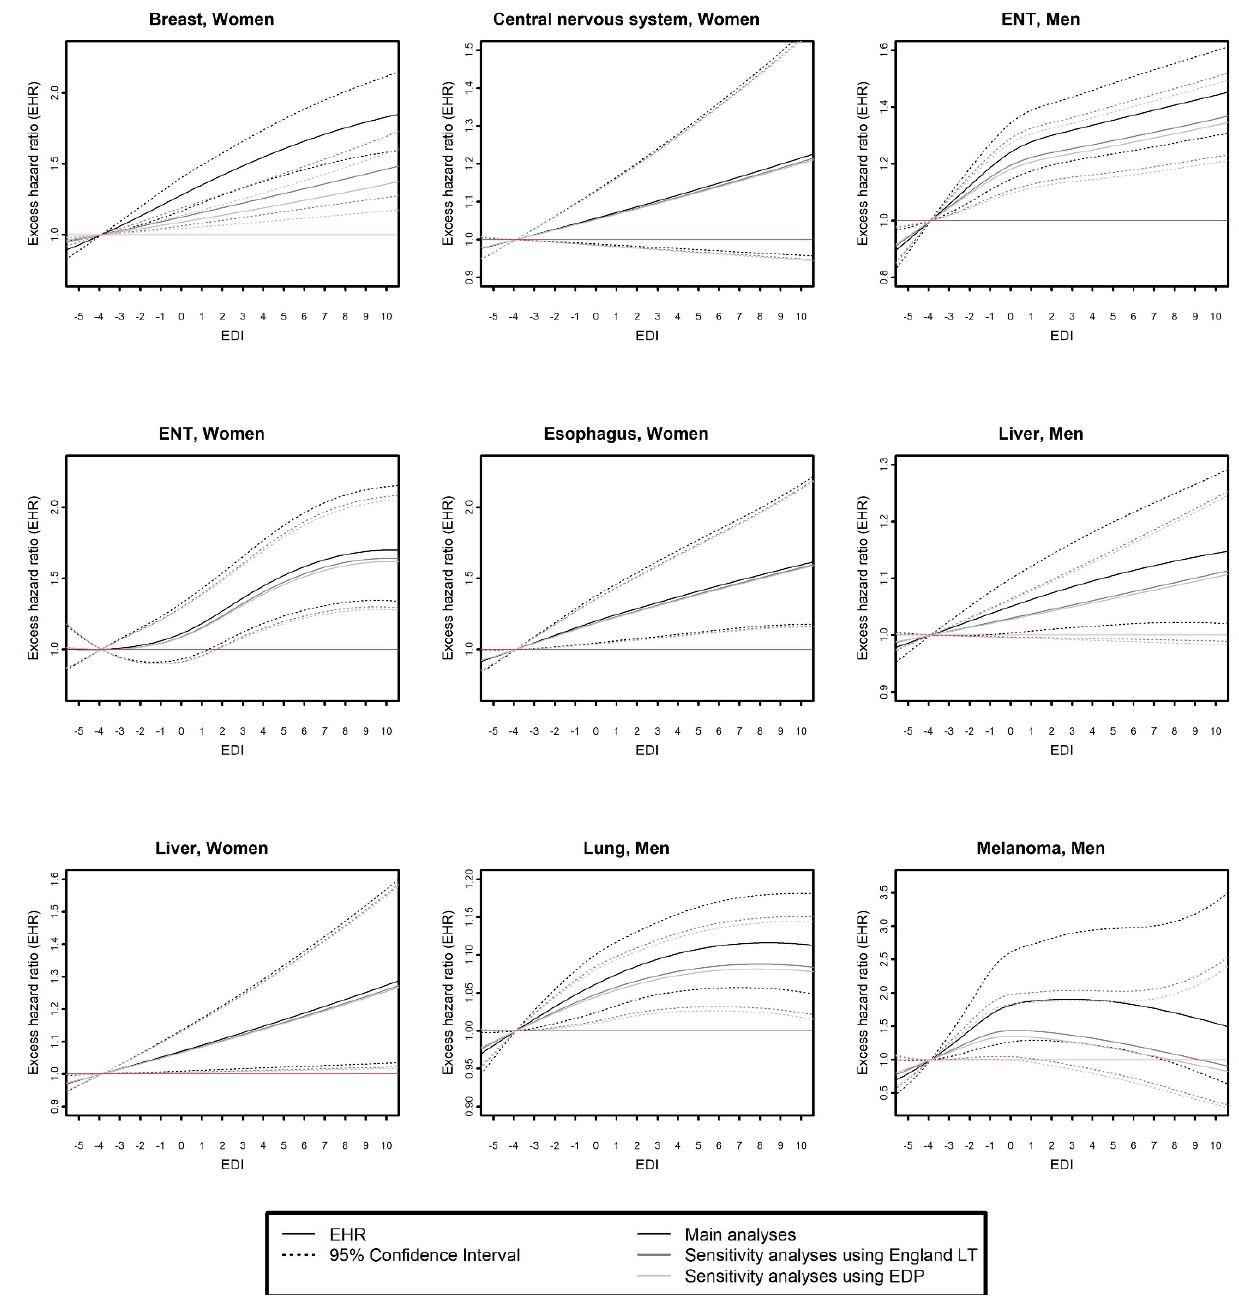
Figure 2. Excess mortality hazard ratio (EHR) as a function of deprivation (EDI) according to main analyses, sensitivity analyses using English life tables, and sensitivity analyses using EDP data, for cancer sites for which all three analyses were concordant (same flexible model selected), and model selection showed an overall proportional effect of EDI on excess mortality hazard (independent of age and time of follow-up). EDI: European Deprivation Index; EDP: French permanent demographic sample [Echantillon Démographique Permanent]; EHR: excess mortality hazard ratio; ENT: ear, neck, throat (head and neck cancers); LT: life tables.